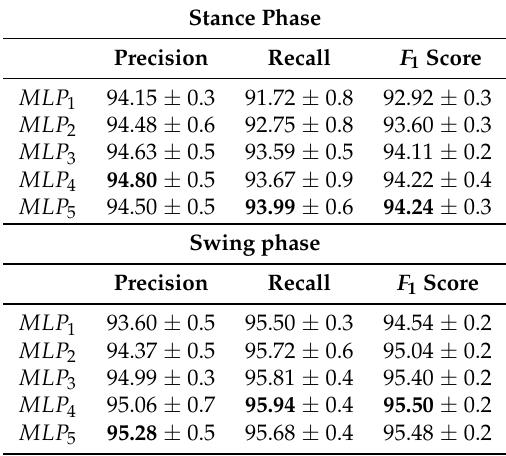
Table 4. Gait phase classification performances for stance and swing phases in learned subjects (set LS-test). Precision, recall and F 1 scores are averaged over the 23